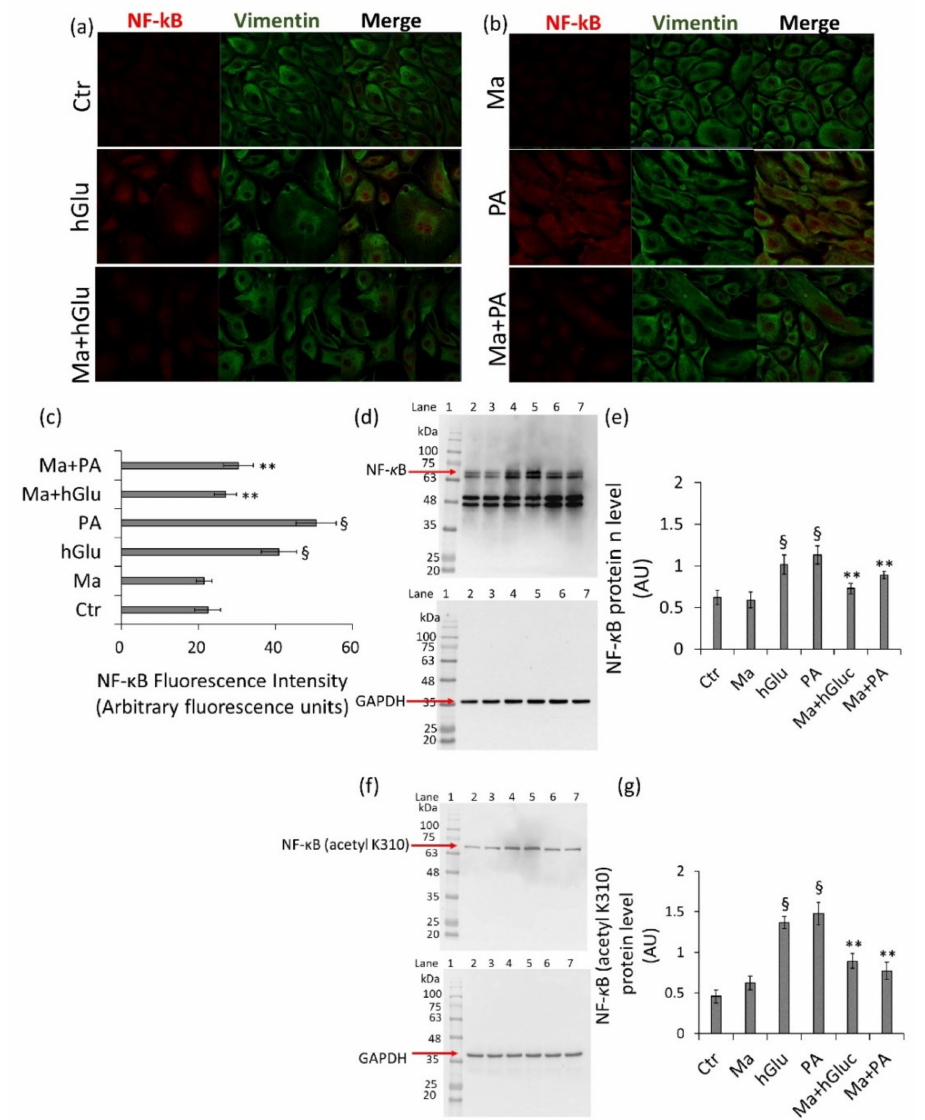
Figure 5. Modulation of NF- κ B by Magliocco. ( a , b ) Representative confocal images of NF- κ B (red) and vimentin (green) and ( c ) fluorescence intensity analysis performed by ImageJ software and expressed as arbitrary fluorescence units (AFU) ± SD of n = 4 replicates. ( d , e ) Western blot analysis of total and ( f , g ) acetylated (acetyl K310) NF- κ B expres- sion levels. Lane 1 = protein ladder molecular weight markers, lane 2 = Ctr, lane 3 = Ma, lane 4 = hGlu, lane 5 = PA, lane 6 = Ma+hGlu, and lane 7 = Ma+PA. The analysis of densitometric intensity was calculated with ImageJ software and expressed as arbitrary units (AU) ± SD of n = 3 replicates. GAPDH was used as the internal control. § p < 0.01 vs. Ctr, and ** p < 0.01 vs. hGlu or